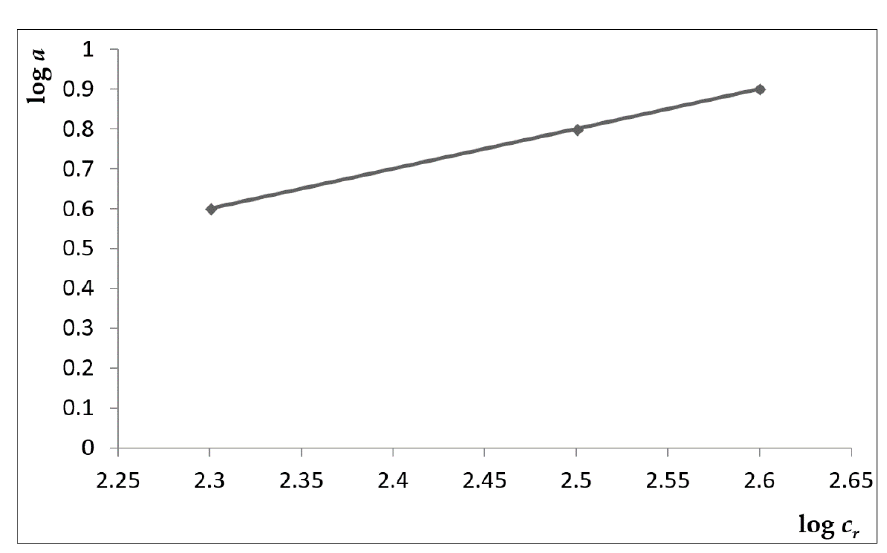
Figure 4. Logarithmic shape of the Freundlich isotherm.